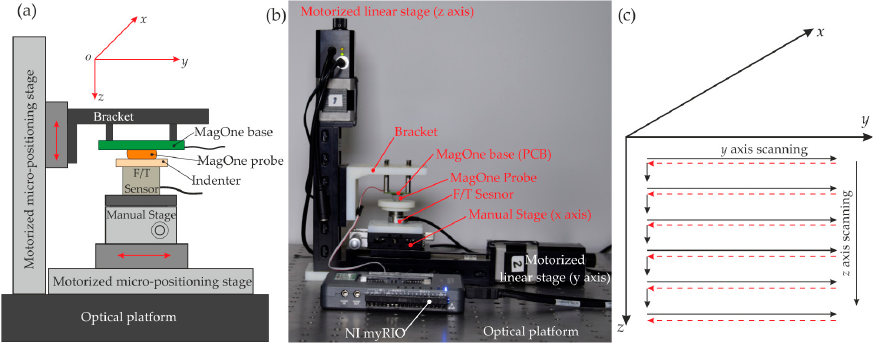
Figure 10. Test platform and calibration: ( a ) The schematic of the test platform; ( b ) A photograph of the test platform; ( c ) 2D scanning track for sensor calibration.